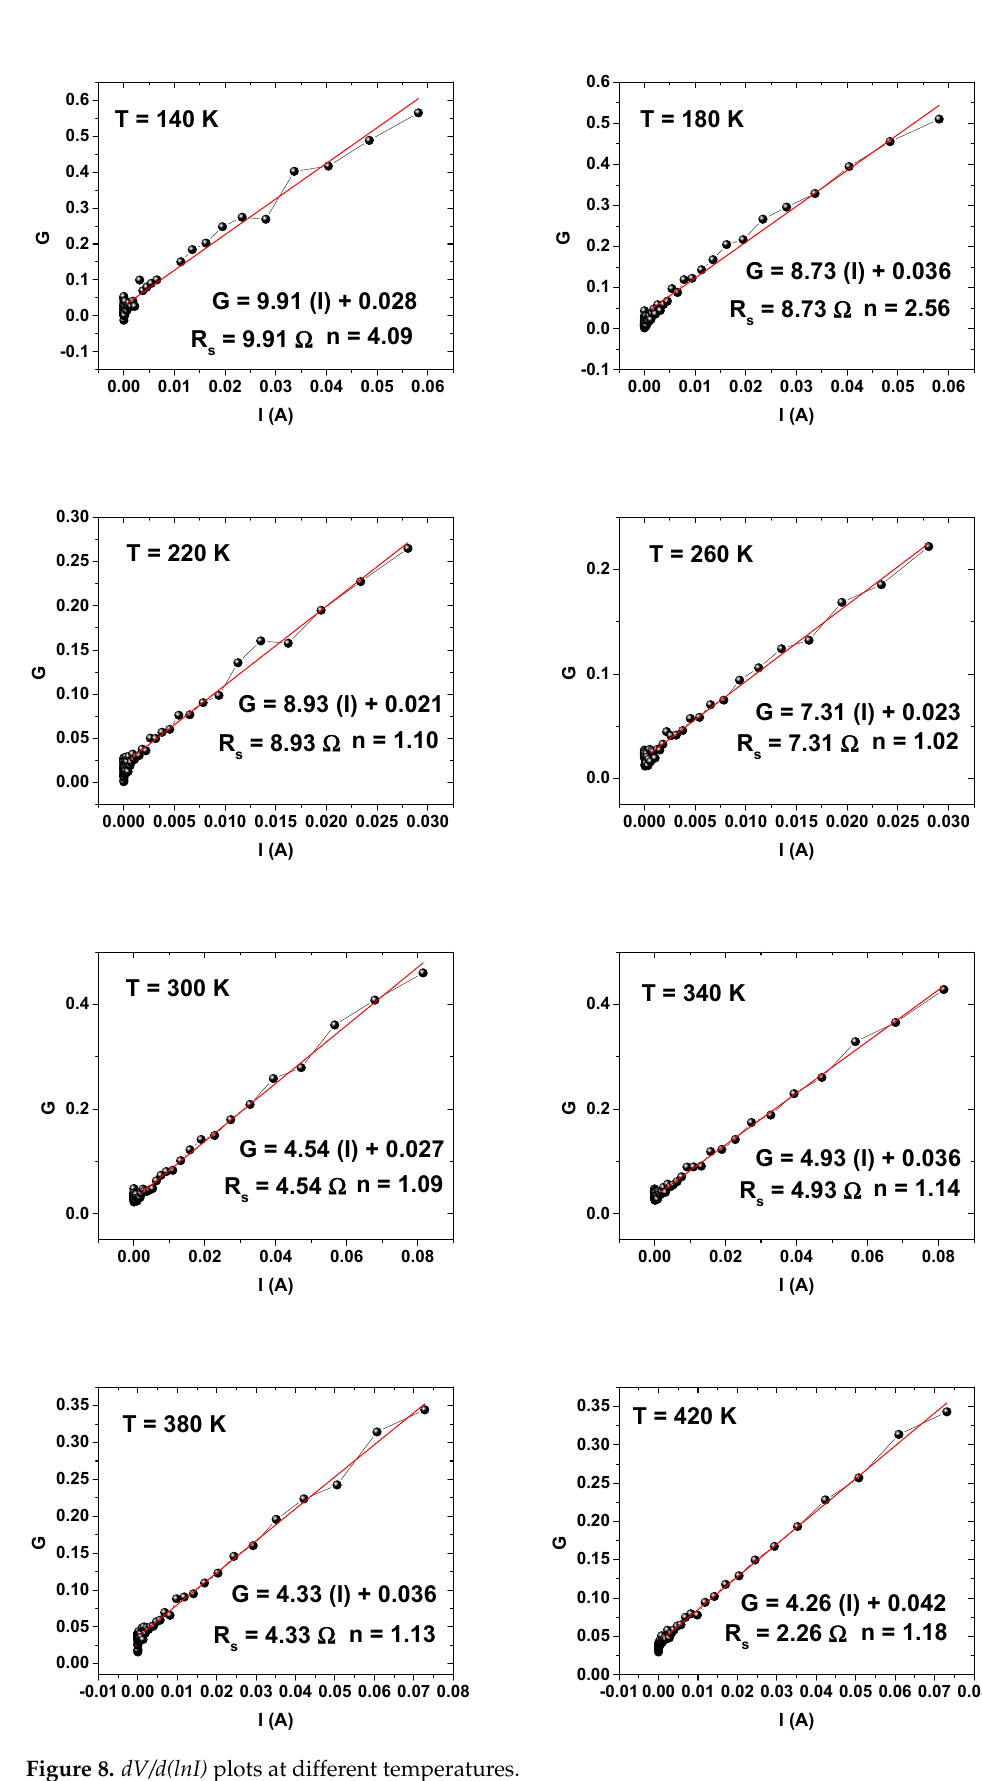
Figure 8. dV/d(lnI) plots at different temperatures. R s and n were extracted by the Cheung and Cheung method for each temperature 200 and presented in Figures 9 and 10, respectively.